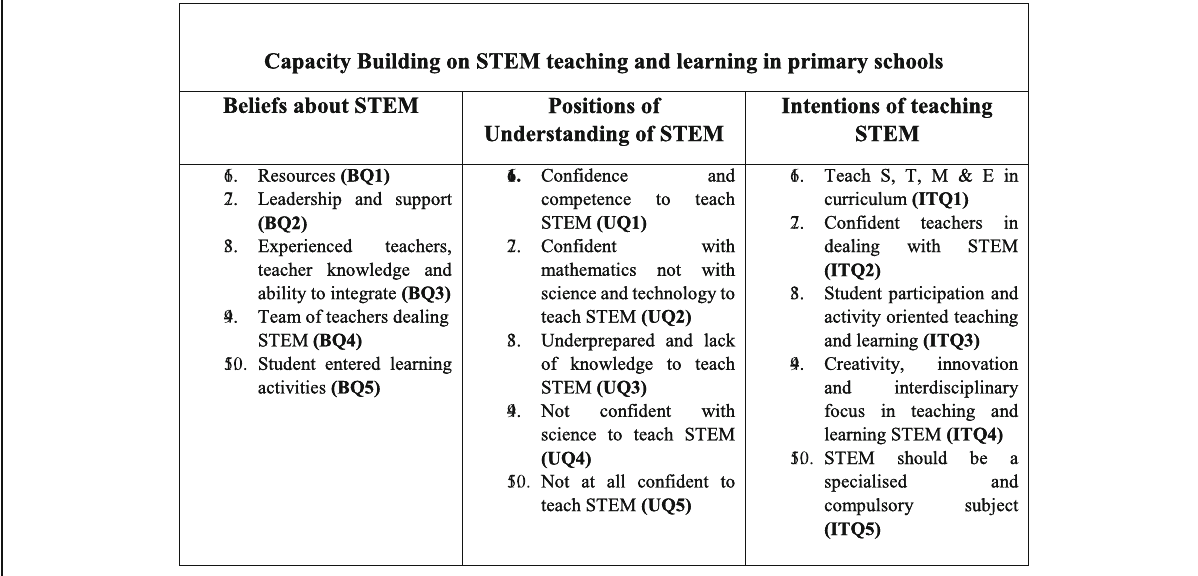
Fig. 4 Overall representation of beliefs, understandings, and intentions of capacity building of STEM among pre-service